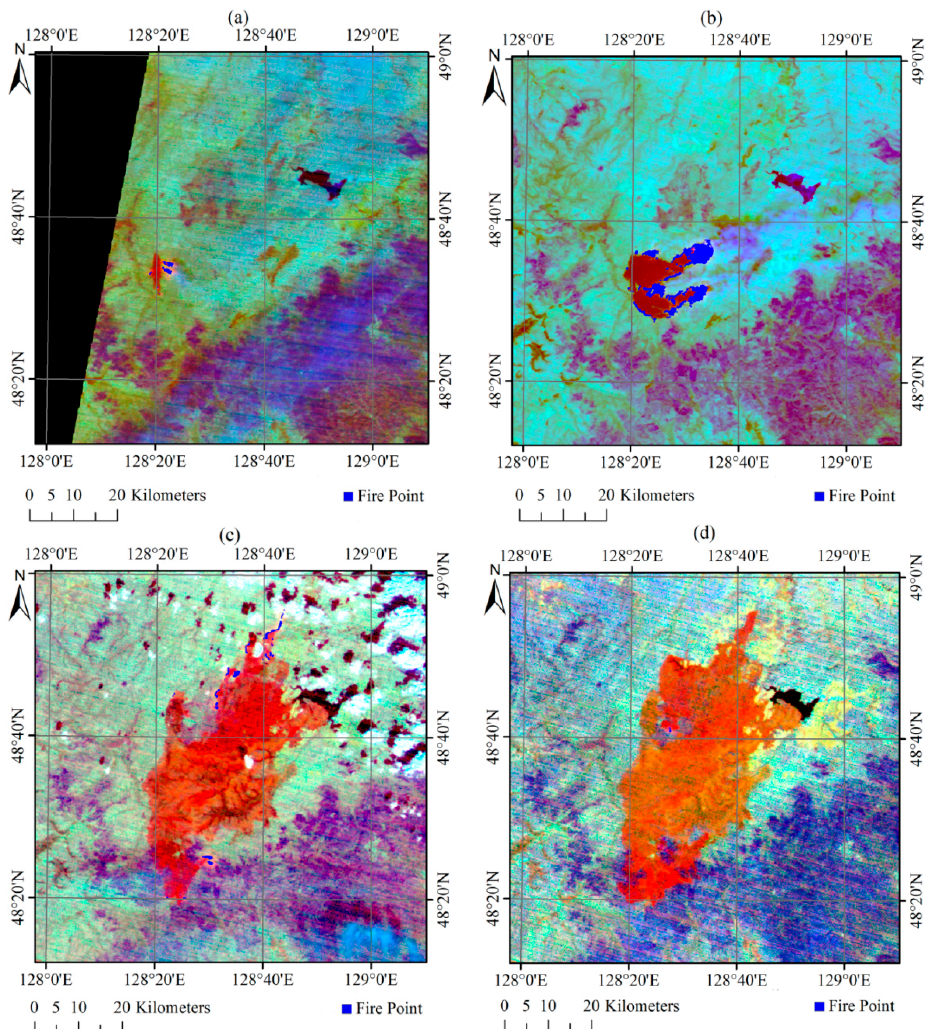
Figure 5. Ground reference data showing the evolution of the fire fronts in the Yinanhe forest on: 28 April 2009 ( a ); 29 April 2009 ( b ); 3 May 2009 ( c ); and 11 May 2009 ( d ).